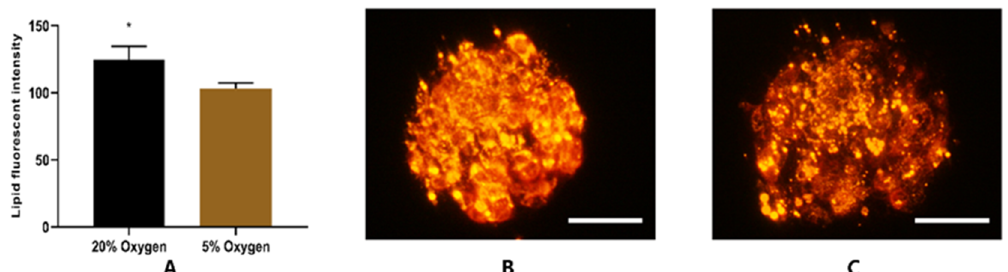
Figure 10. Fluorescent analysis of Lipid. Embryos cultured under atmospheric oxygen showed higher fluorescent intensity ( A ). Photomicrographs of Nile Red stained blastocysts: ( B ) 20% Oxygen and ( C ) 5% Oxygen. The images (Figure 10B and 10C) were captured with microscope (50i; Nikon, Japan) at 200× resolution. Asterisk (*) indicates the significant difference ( p < 0.05) between the groups.